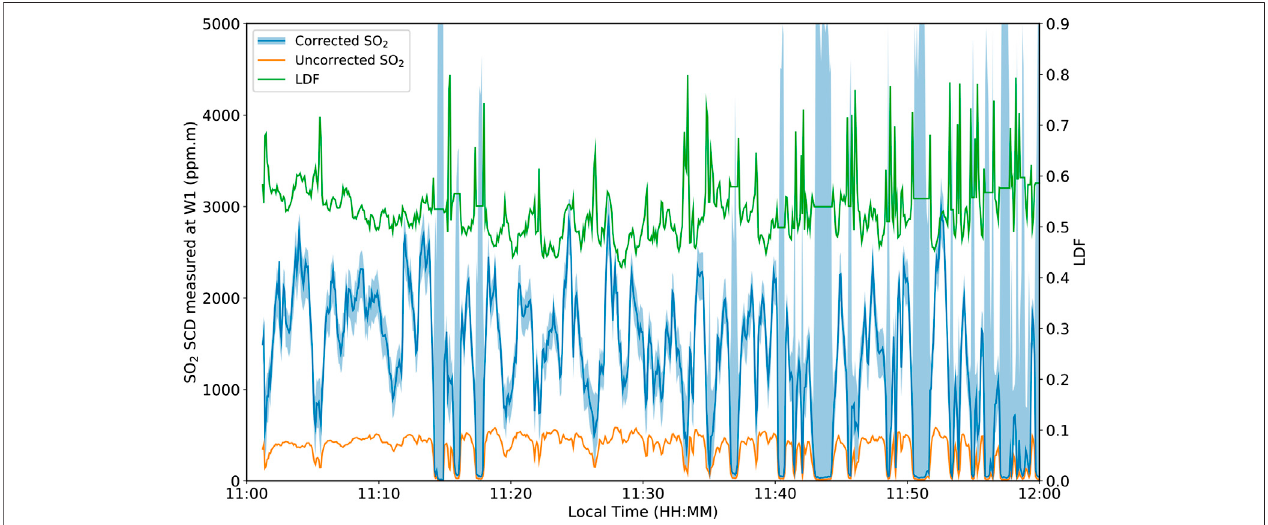
FIGURE8| The retrieved SO 2 time series before correction (orange) and after correction(blue).TheSO 2 error determined from thelookup table isincluded aslight blue shading. The correction is poorly constrained for low SO 2 SCDs. The light dilution time series is included (green).